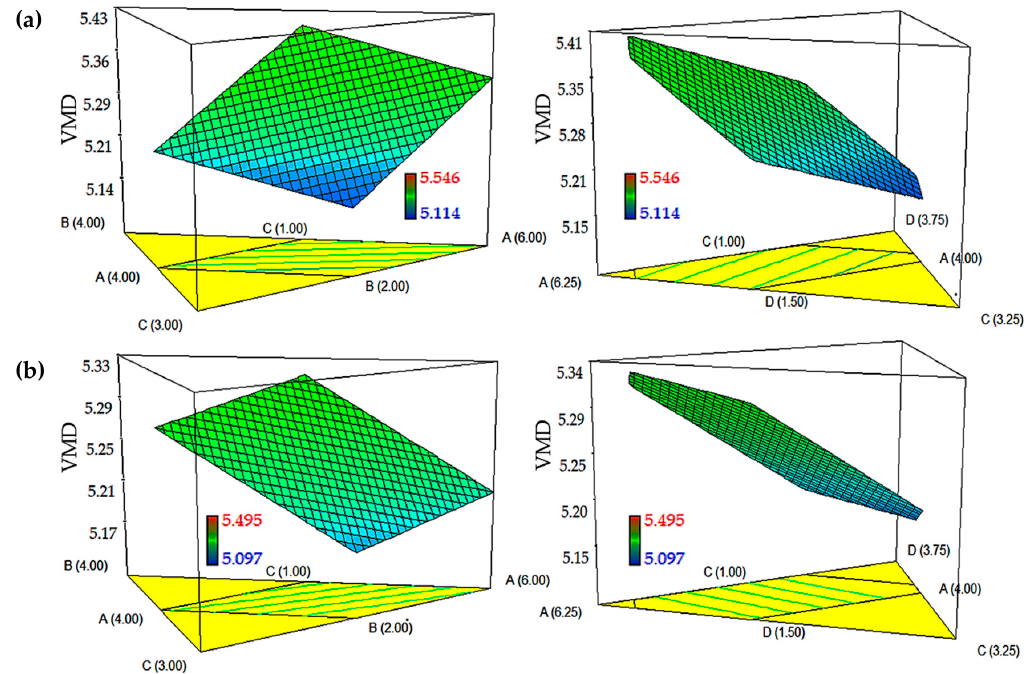
Figure 3. Graphical plots of ( a ) DTX-loaded nanoemulsion and ( b ) CCM-loaded nanoemulsion compositions toward VMD. The models show the interaction between independent variables including A: PKOE and Safflower seed oil mixture (1:1; w / w ), B: lecithin, C: surfactant mixture of Tween 85 and Span 85 (9:1; w / w ), and D: glycerol, while water was kept constant.